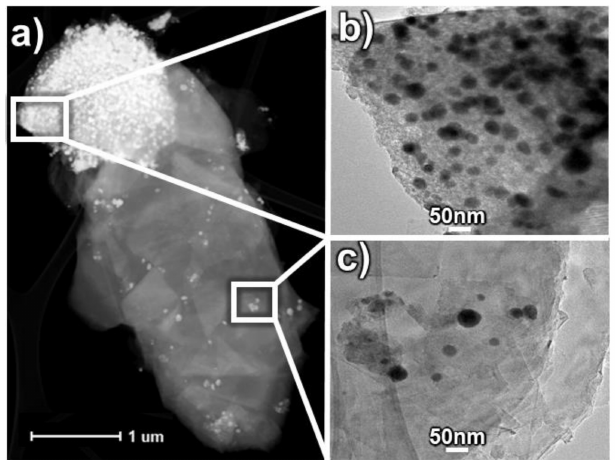
Figure 4. TEM pictures of ( a ) SiOC/Sn-40% and ( b ) SiOC:C 0.2 /Sn-60% composites.